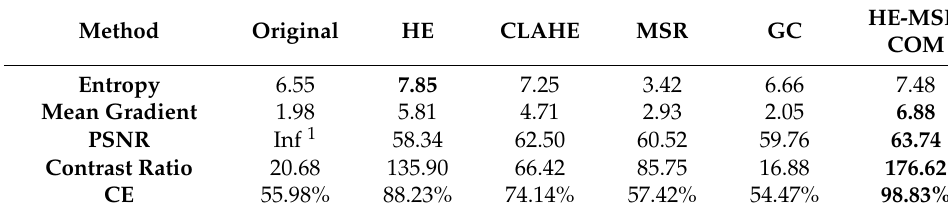
Table 4. Mean performance comparison in Cityscapes.